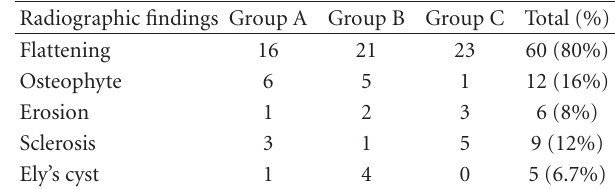
Table 1: Prevalence of radiographic condylar changes according to age. Age group